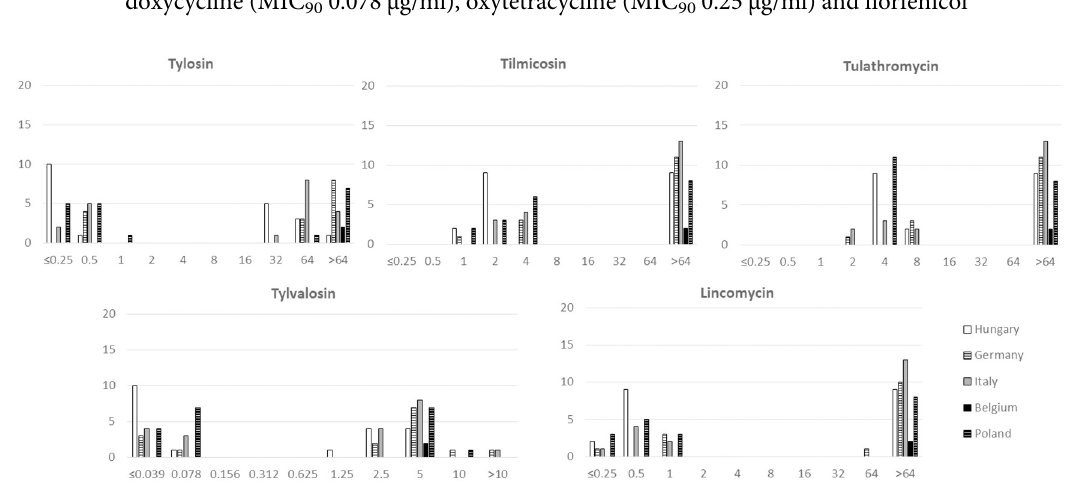
Fig 1. Minimal inhibitory concentration (MIC) distribution of the 76 tested Mycoplasma hyorhinis isolates for macrolides (tylosin, tilmicosin, tylvalosin, tulathromycin) and lincomycin by country of origin. X-axis: concentration of the